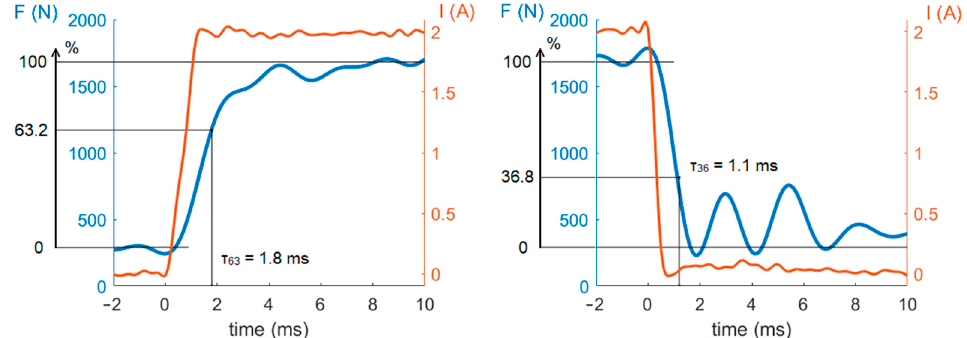
Figure 5. Example of measured response time for rise ( left ) and drop ( right ). I (A) is the measured electric current, and F (N) is the measured damping force.